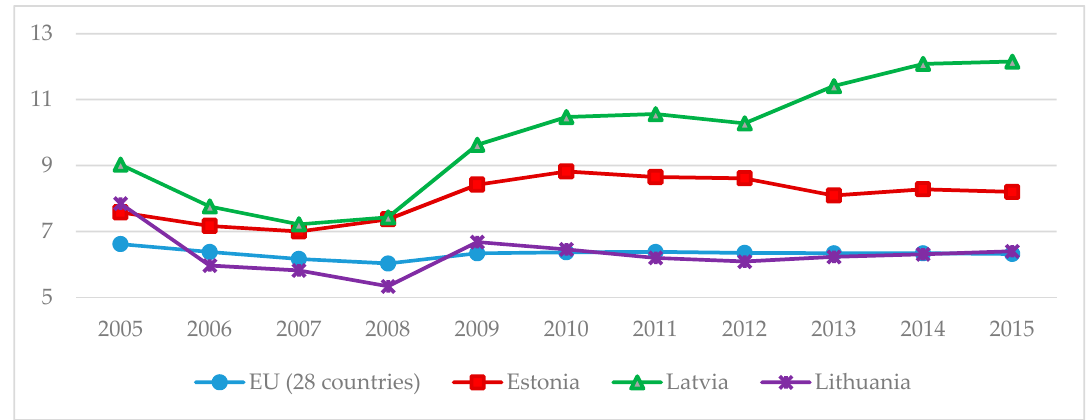
Figure 4. Dynamics of revenues from environmental taxes in the Baltic States, as the percentage of total taxes and social contributions.